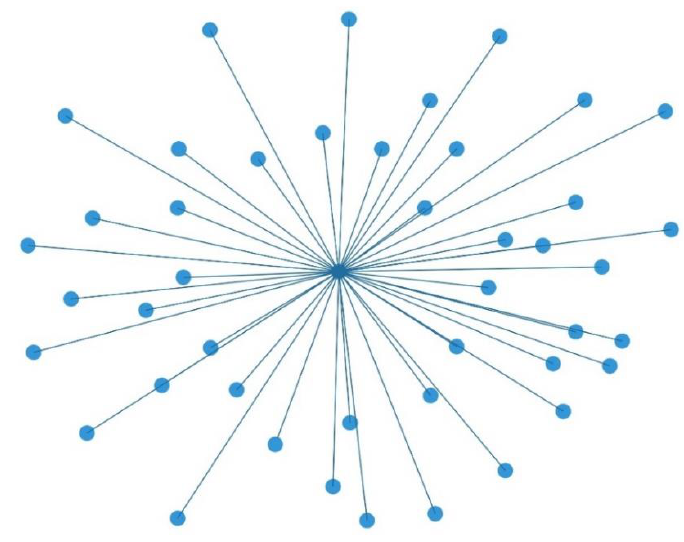
Figure 2. Centralized architecture.